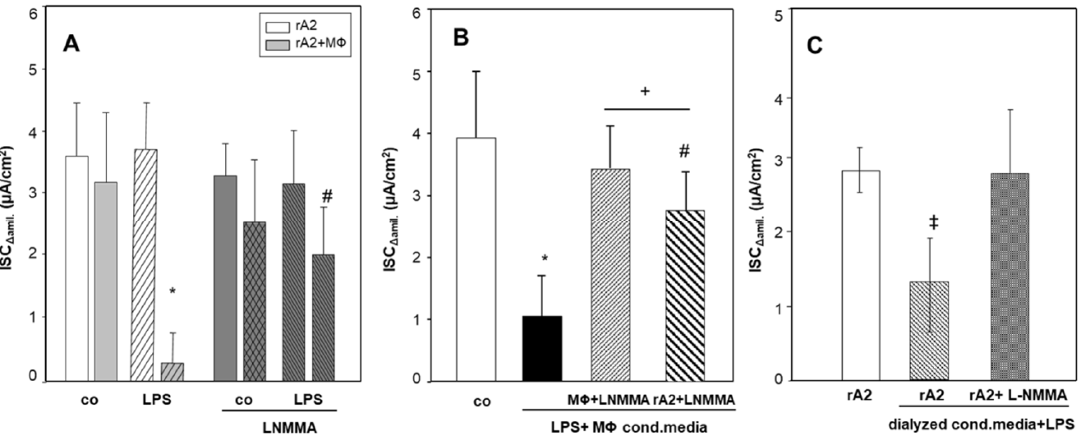
Figure 3. Effect of inhibiting of iNOS activity with LNMMA on ion transport activity in co-cultures and cells exposed to LPS stimulated conditioned media. Mono and co-cultures of rA2 cells with alveolar macrophages were pretreated with L-NMMA (1 mM) for 30 min prior to LPS (1 µg/mL) stimulation. ENaC activity was measured as the amiloride (10 µM) sensitive component of I eq in Ussing chambers (ISC Δ amil ) ( A ). Conditioned macrophage media from mono-cultures of macrophages treated with LPS (1 µg/mL) and L-NMMA (1 mM) was kept on rA2 cell monolayers and on macrophages for 24 h. ( B ). Conditioned macrophage media from mono-cultures of macrophages treated with LPS (1 µg/mL) were dialyzed and kept on rA2 monolayers for 24 h, in parallel rA2 cells treated with L-NMMA (1 mM) 30 min prior receiving LPS treated conditioned media ( C ). Mean values ± SD of 4–6 experiments from at least 3 independent preparations of primary rA2 cells. * effect of LPS treatment of co-cultures and conditioned media p < 0.001; + effect of L-NMMA, # effect of L-NMMA treatment of rA2 cells compared to M Φ + L-NMMA, ‡ e ff ect of dialysis p < 0.001. M Φ : rat alveolar macrophages; rA2: rat alveolar epithelial cells.